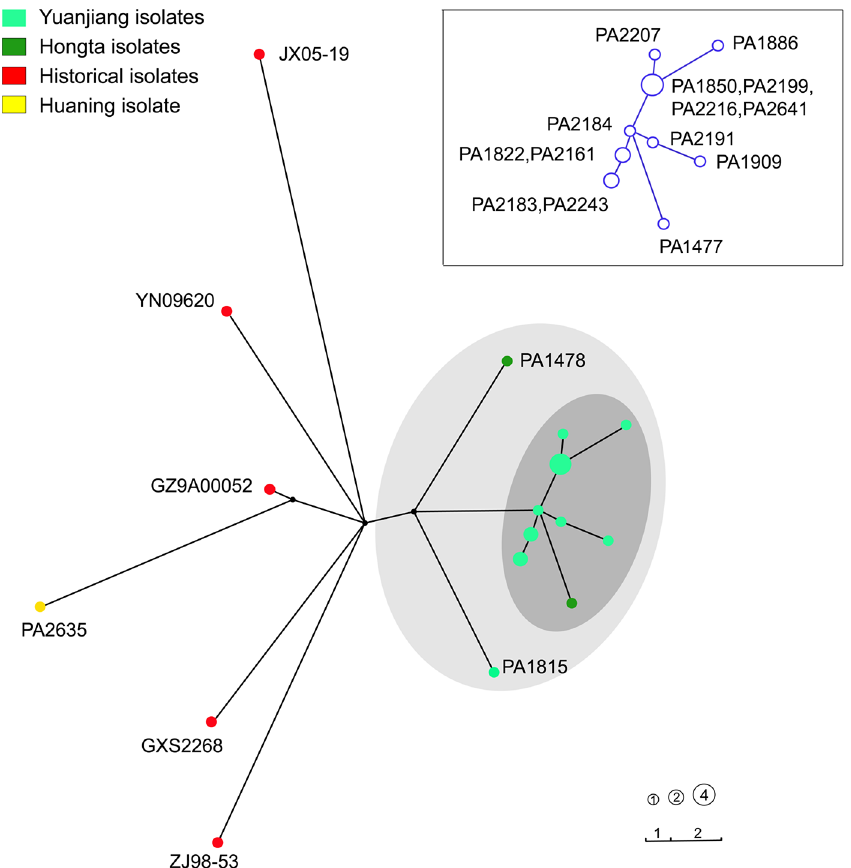
Fig 4. Maximum likelihood tree of 22 S . Paratyphi A isolates based on 270 SNPs. In the tree, the sources of the strains are represented by different colors. The types are displayed as circles. The size of each circle represents the number of isolates within this type; the length of each line linking two circles represent the number of SNPs between two types. The isolates possessing common SNP types in the Yuanjiang outbreak are marked with the dark-gray ellipse; one Yuxi isolate is also included. The gray ellipse includes all the Yuanjiang and Yuxi isolates. The isolate codes in the dark-gray ellipse are marked in a copy of these branches in the upper